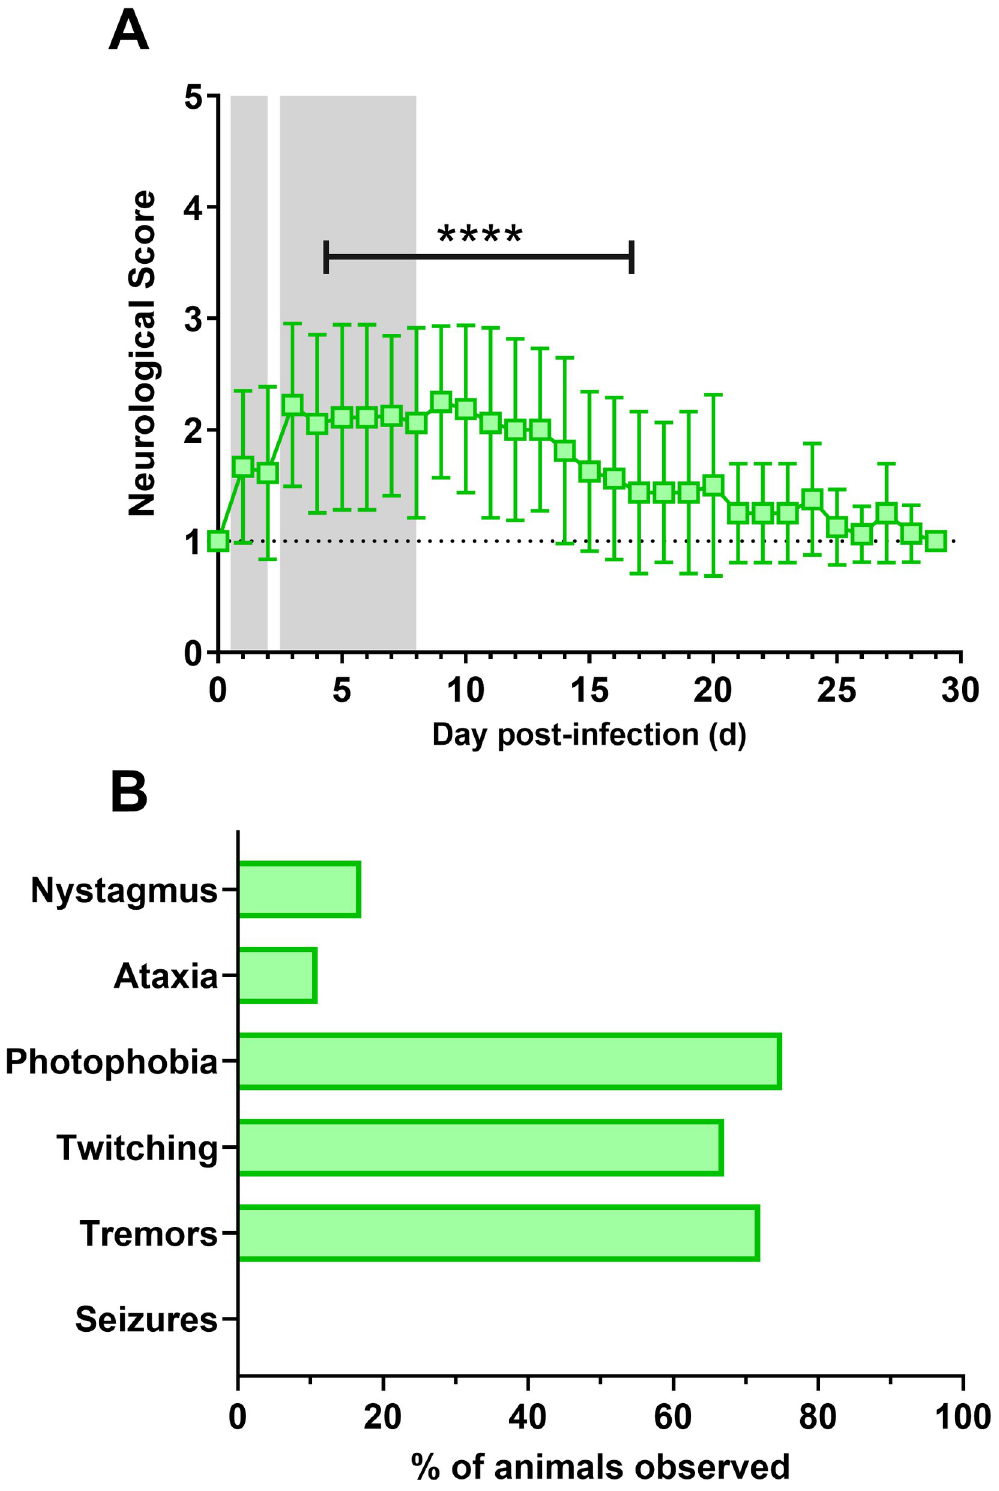
Fig 3. Neurological scores and clinical observations during VEEV infection. Animals were observed at least once daily by research staff, scored according to IACUC-approved parameters, and clinical observations were recorded. (A) daily neurological scores (+/- SD). Asterisks indicate scores that are significantly above pre-infection levels based on one-way ANOVA analysis with multiple comparisons. (B) frequency of clinical observations from (n = 18).